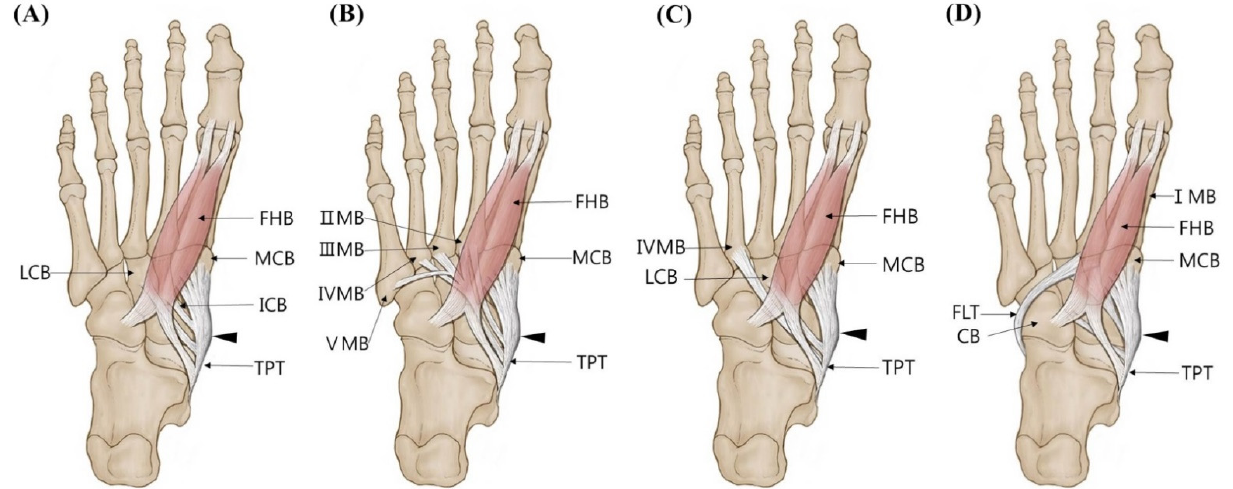
Figure 5. Schematic drawing of the Type 4 tibialis posterior tendon insertion. Black-colored arrow indicates TPT inserts to the navicular bone. ( A ) Type 4K-1. ( B ) Type 4K-2. ( C ) Type 4K-3. ( D ) 4K-4. TPT, tibialis posterior tendon; MCB, medial cuneiform bone; ICB, intermediate cuneiform bone; LCB, lateral cuneiform bone; FHB, flexor hallucis brevis; I, II, III, IV, V MB, first, second, third, fourth, fifth metatarsal bones; FHB, flexor hallucis brevis; CB, cuboid bone; FLT, fibularis longus tendon.